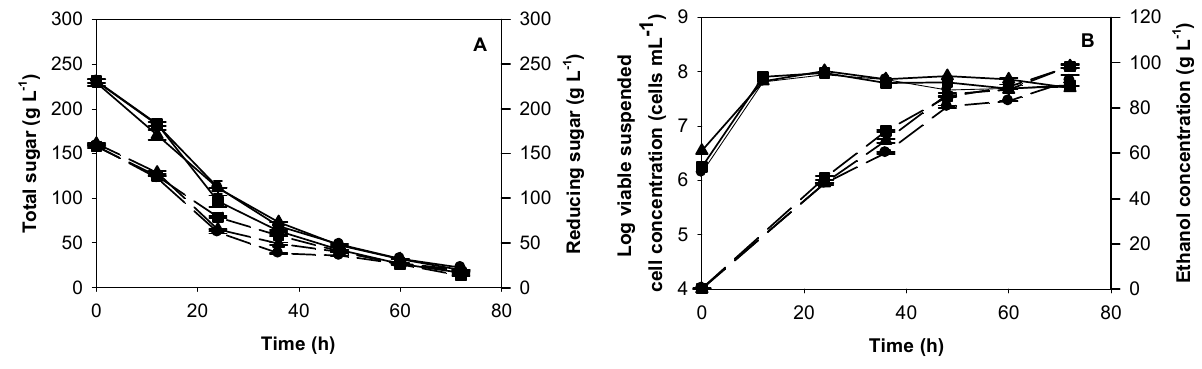
Figure 2. Batch culture profiles of ethanol production from sweet sorghum juice by S. cerevisiae NP 01 immobilized on 6 × 6 × 6 mm 3 sorghum stalks. The immobilized yeast cells were prepared at different initial cell concentrations in YM medium: ( ● ) = 0.5 × 10 8 , ( ▲ ) = 1.0 × 10 8 and ( ■ ) = 2.0 × 10 8 cells mL − 1 . ( A ) total sugar (solid lines) and reducing sugar (dash lines); ( B ) log viable suspended cell concentration (solid lines) and ethanol concentration (dash lines).